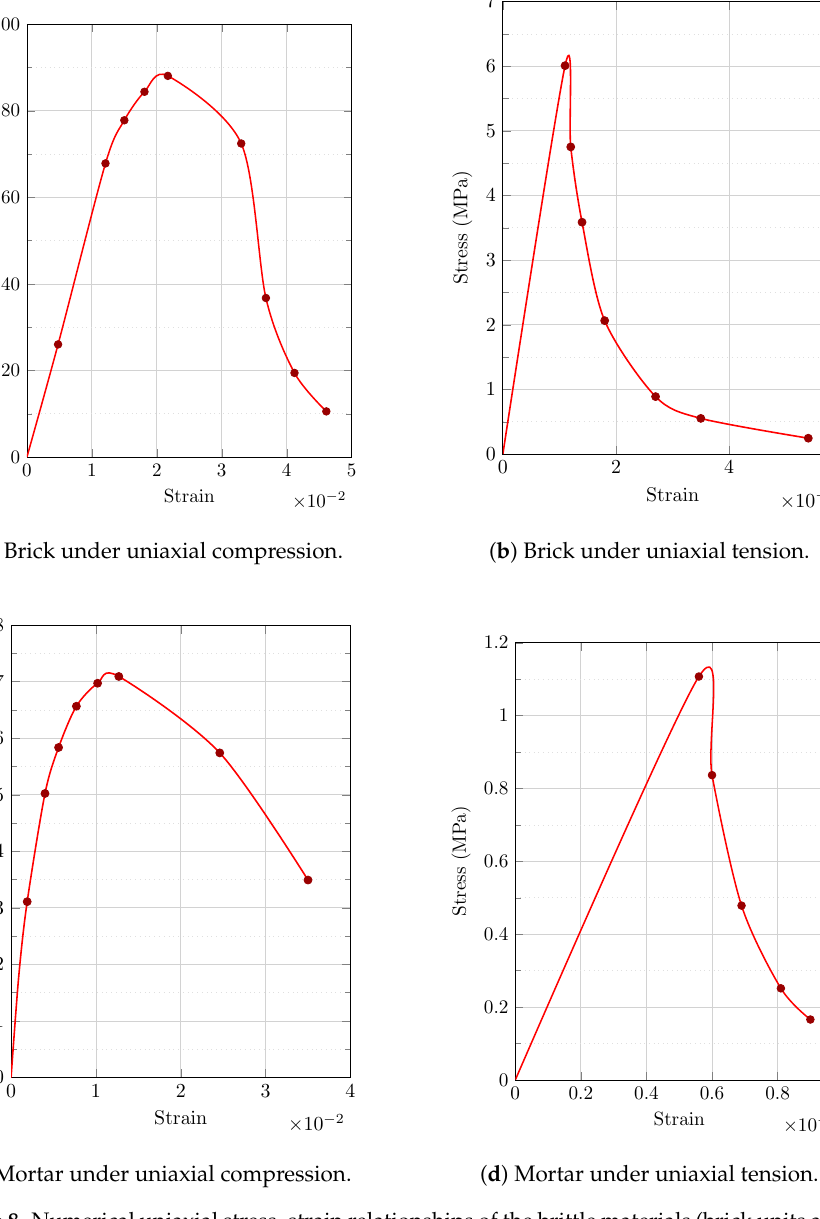
Figure 8. Numerical uniaxial stress–strain relationships of the brittle materials (brick units and mortar joints) used in this study: ( a ) brick under compression; ( b ) brick under tension; ( c ) mortar under compression; ( d ) mortar under